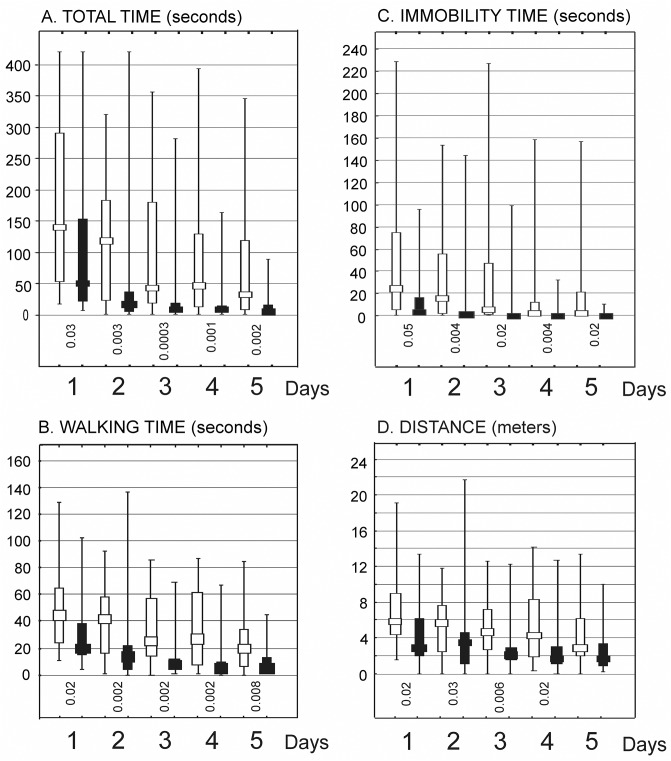
Exemplary parameters of the animal behavior during five-day maze tests performed/repeated at the 9th month of age.(A) the total time (seconds) spent in the maze before the reward was reached by the animal on day 1st, 2nd, 3rd, 4th, and 5th, (B) the time of walking (seconds) to reach the reward, (C) the time of immobility (seconds), (D) the total walking distance (meters). Abbreviations: White and black graphs characterize control and high-fat high carbohydrate diet-treated animals, respectively. The graphs show median values (squares), 25–75% variability ranges (vertically arranged rectangles), and maximal and minimal values (whiskers). Decimal indexes located below the graphs indicate statistical significance of intergroup differences at a given maze test (Mann–Whitney U-test).